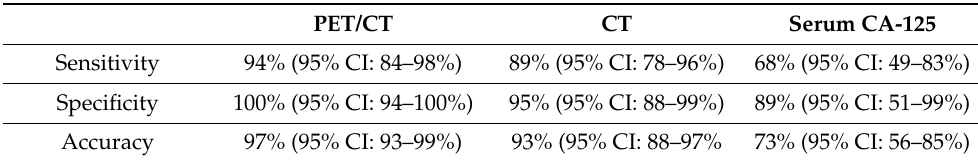
Table 4. Performance of PET/CT in detecting recurrence of LGSCs compared to CT scan and serum CA-125 alone [58]. PET/CT CT Serum